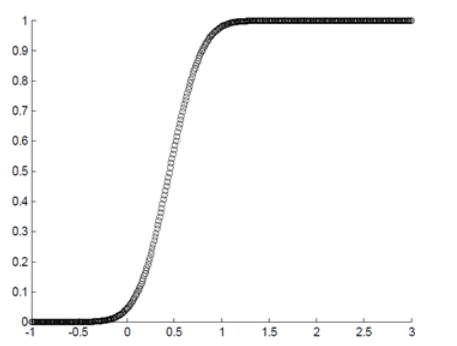
Figure 1 - Prevision index in a frequentist test case where .